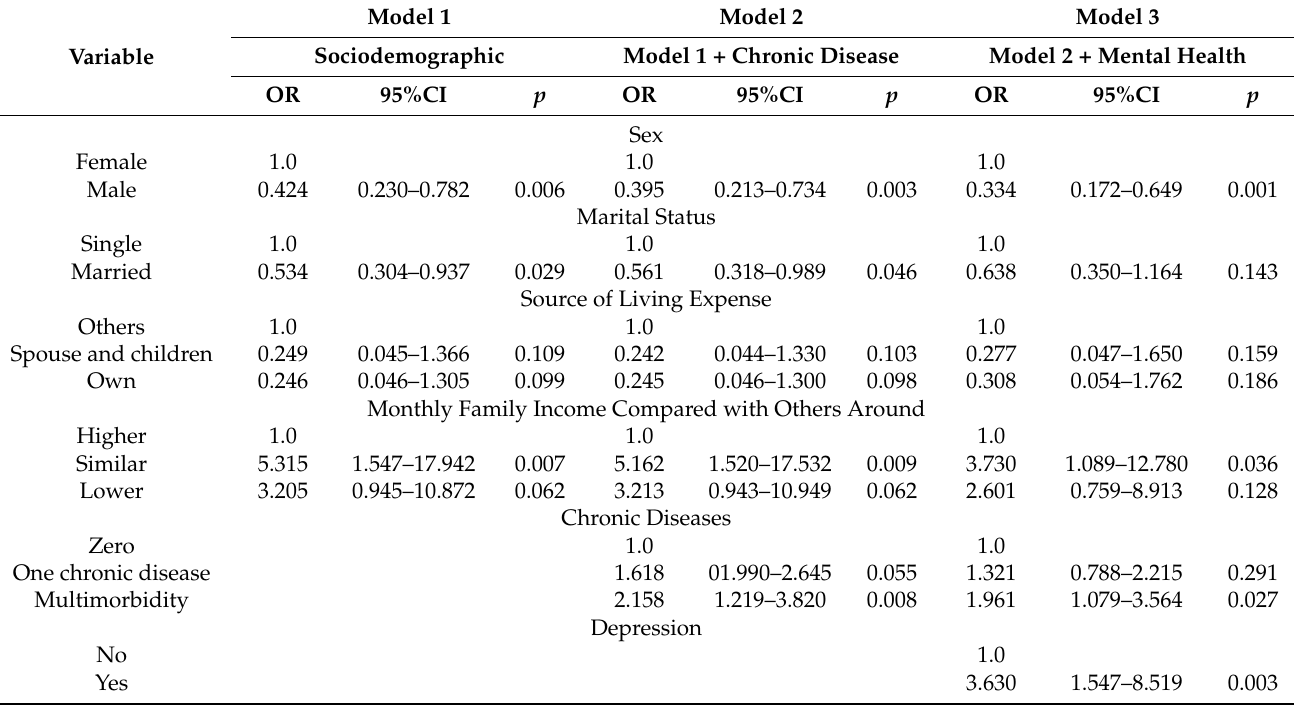
Table 3. Logistic regression analysis on the association between sociodemographic characteristics, chronic disease, mental health, and sleep quality among